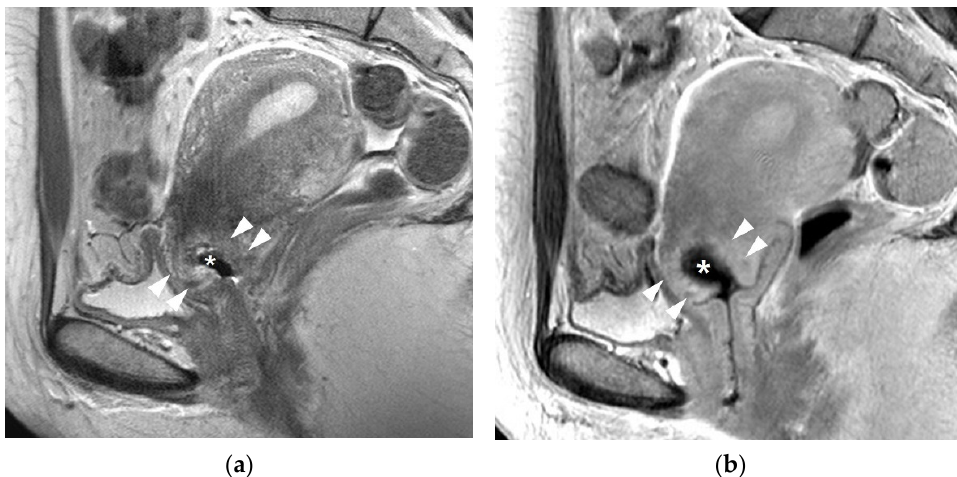
Figure 2. A 42-year-old woman with IA1 cervical cancer: ( a ) T2-weighted sagittal image showed a cone-shape defect (asterisk) after cone biopsy. Arrowheads indicate a poorly demarcated hyperintense lesion indicating post-biopsy inflammation. ( b ). Delayed contrast-enhanced sagittal image shows a hematoma (asterisk) within the cone biopsy defect. Arrowheads indicate a poorly demarcated enhancement indicating post-biopsy inflammation around the tissue defect. Neither residual cancer nor parametrial invasion was detected postoperatively.